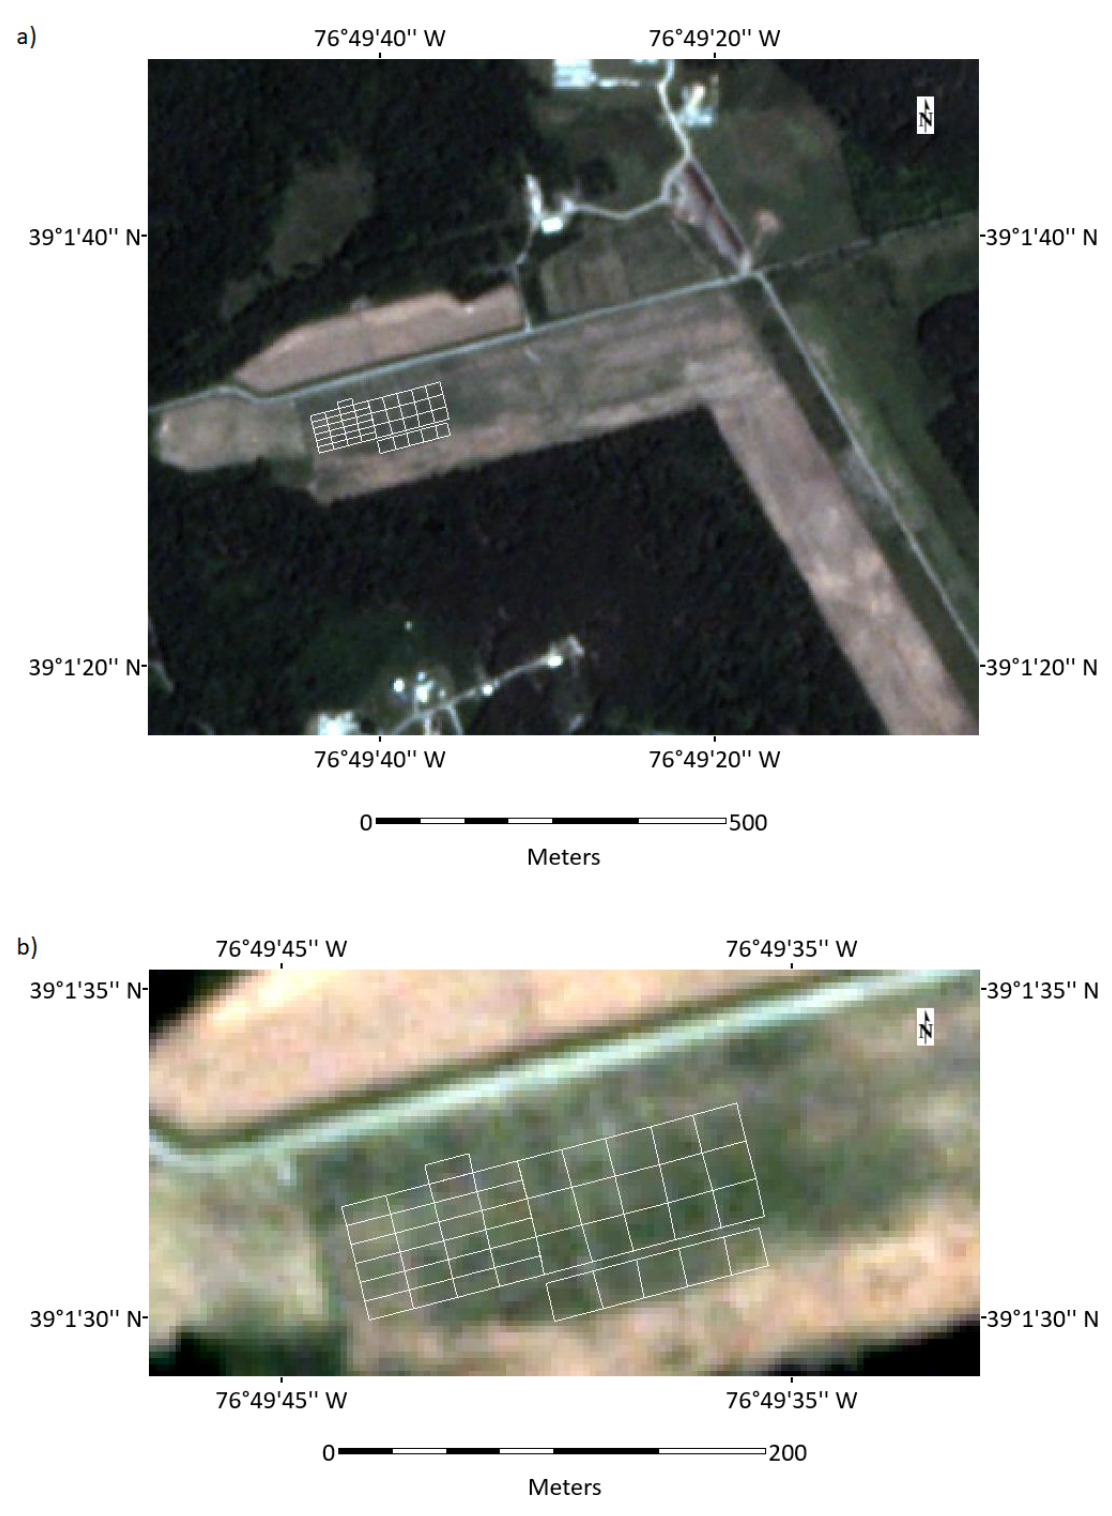
Figure 1. ( a ) View of the field and plot locations. ( b ) contrast-enhanced, closer view of the plots. Both images show RGB surface reflectance, derived from imagery collected by a PlanetScope satellite on 16 June 2018. Each plot is represented as a white box. The smaller plots are roughly 9 by 21 m, and the larger plots are roughly 18 by 21 m. The plots in the third and fourth columns from the left (the two columns of small plots closest to the larger plots) were excluded from analysis due to treatment